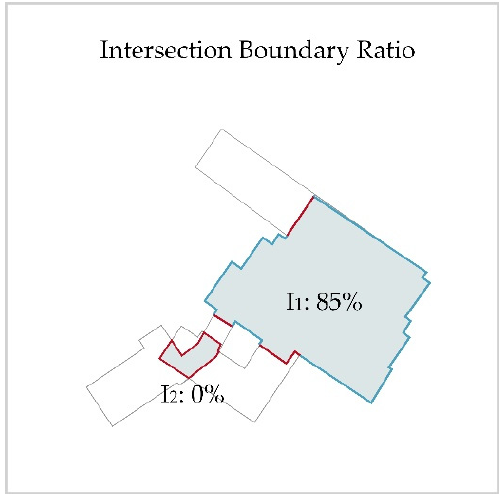
Figure 4. Example of Intersection Boundary Ratio ( IBR ) calculated separately for each area of intersection I 1 and I 2 (same input objects T1 and T2 as in Figure 3). Blue lines show matching of line segments from T1 and T2, red lines do not match between T1 and T2, and gray is the overlapping area.